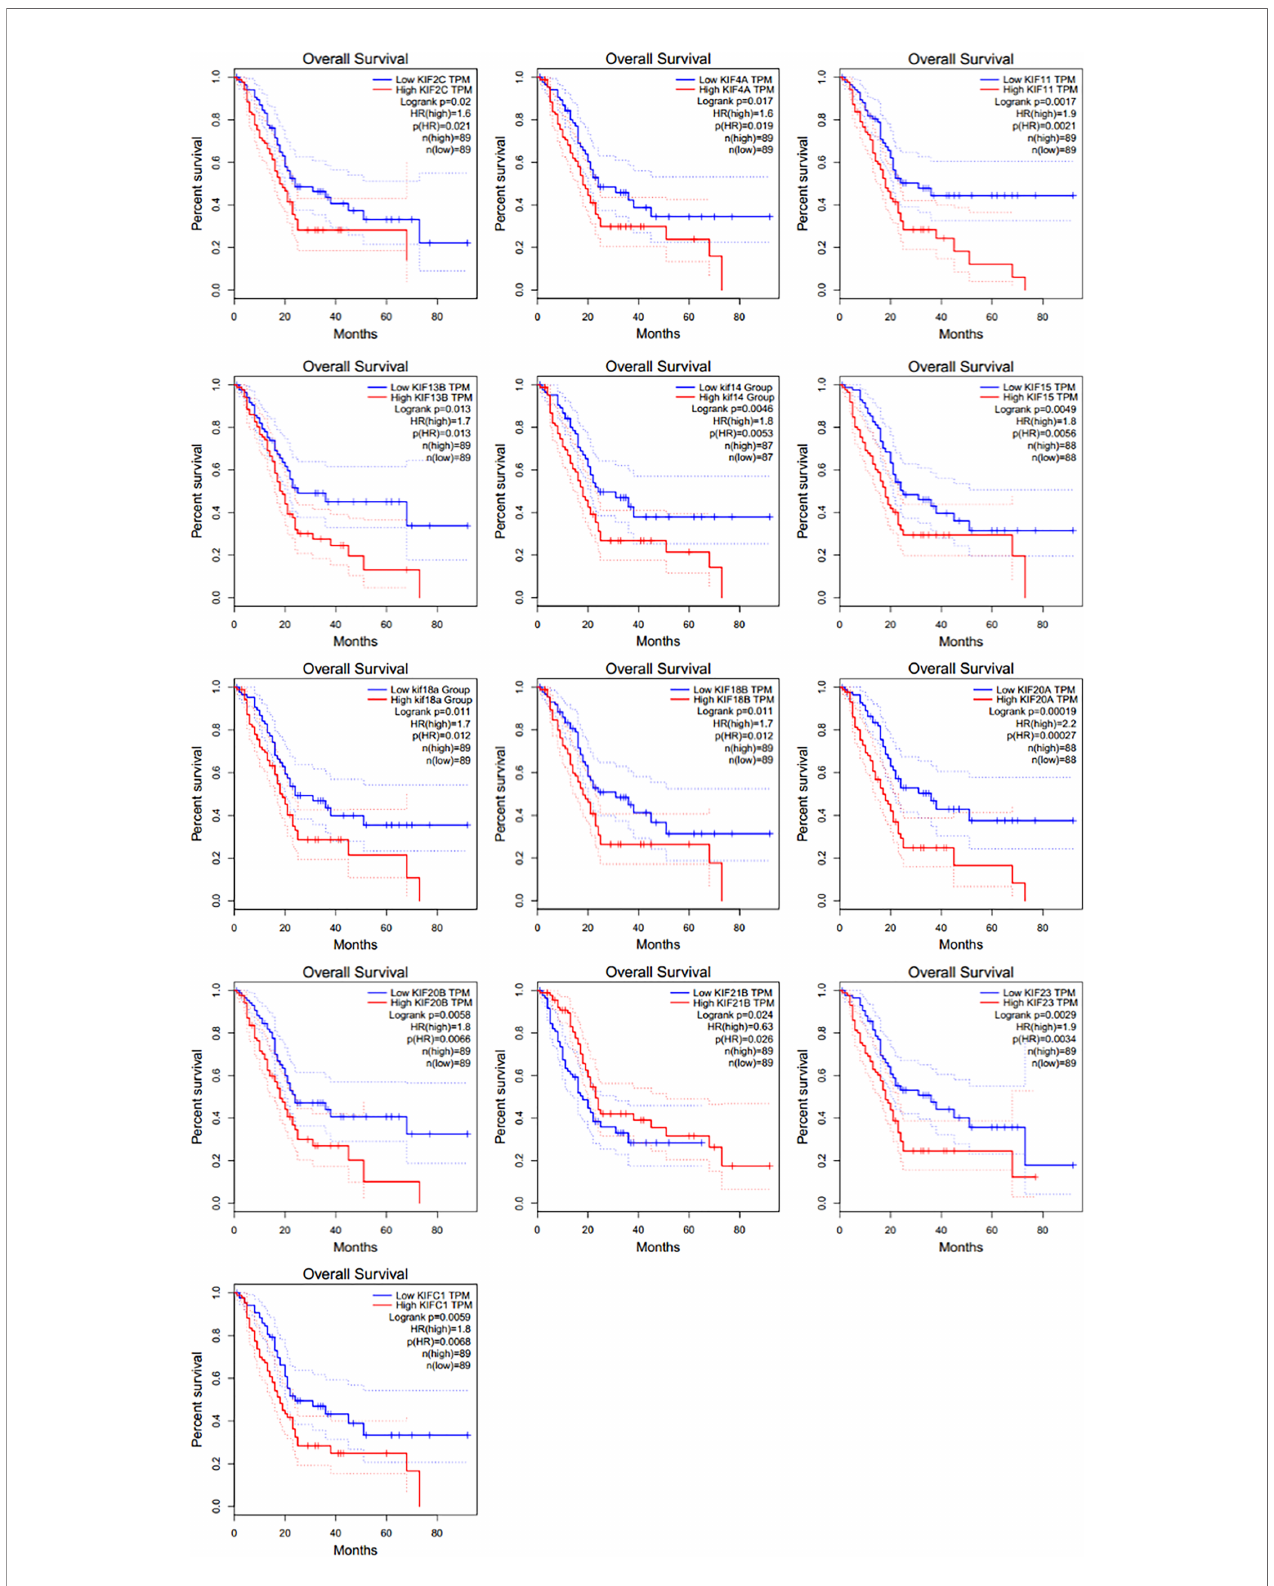
FIGURE 2 | The prognostic value of KIFs in PDAC patients in the OS curve (GEPIA). Overall survival analyses of 13 prognostic genes (KIF2C, KIF4A, KIF11, KIF13B, KIF14, KIF15, KIF18A, KIF18B, KIF20A, KIF20B, KIF21B, KIF23, and KIFC1) at pancreatic cancer based on the GEPIA database.